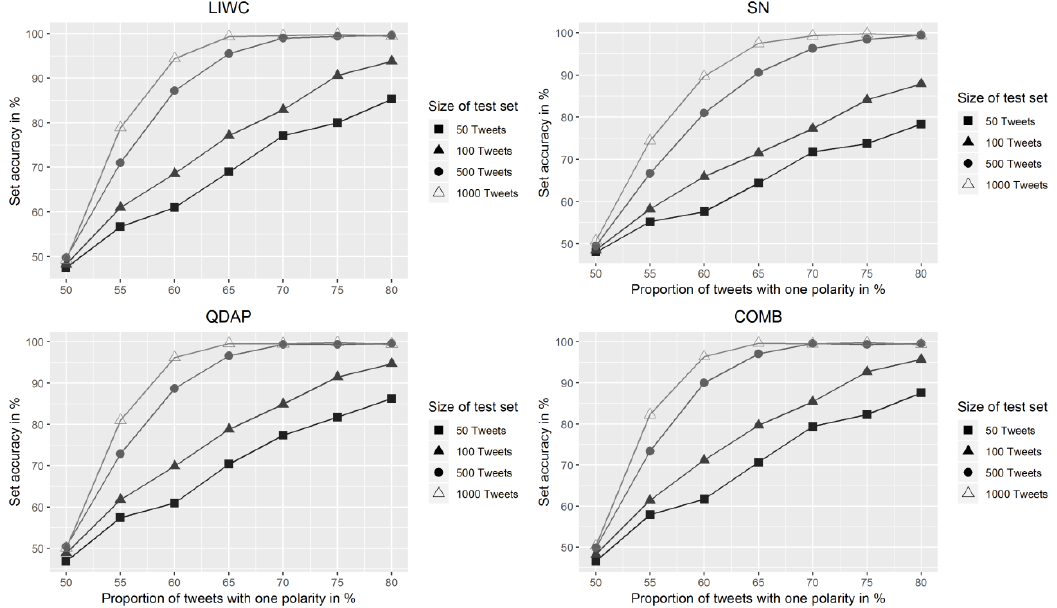
Figure 1. Set accuracies for various numbers of tweets (n) and proportions of polarity (p) based on 10,000 repetitions.